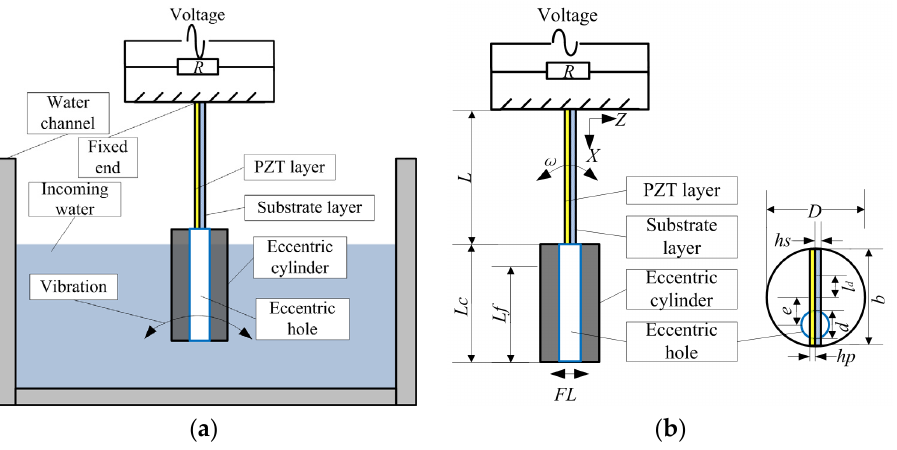
Figure 1. Energy harvester: ( a ) Harvester and its working environment; ( b ) Schematic of harvester.